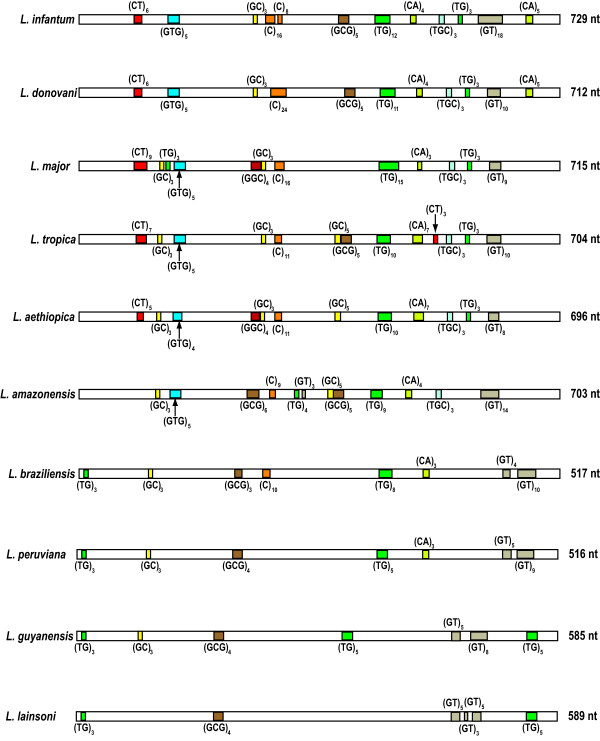
Microsatellite distribution in the 3’-UTR ofHSP70-Igenes in severalLeishmaniaspecies. The repeated motifs correspond to those found in the sense strand. Note that the drawing scale is not proportional for the different Leishmania species; however, for a given sequence, the relative positions of the microsatellites are scaled.